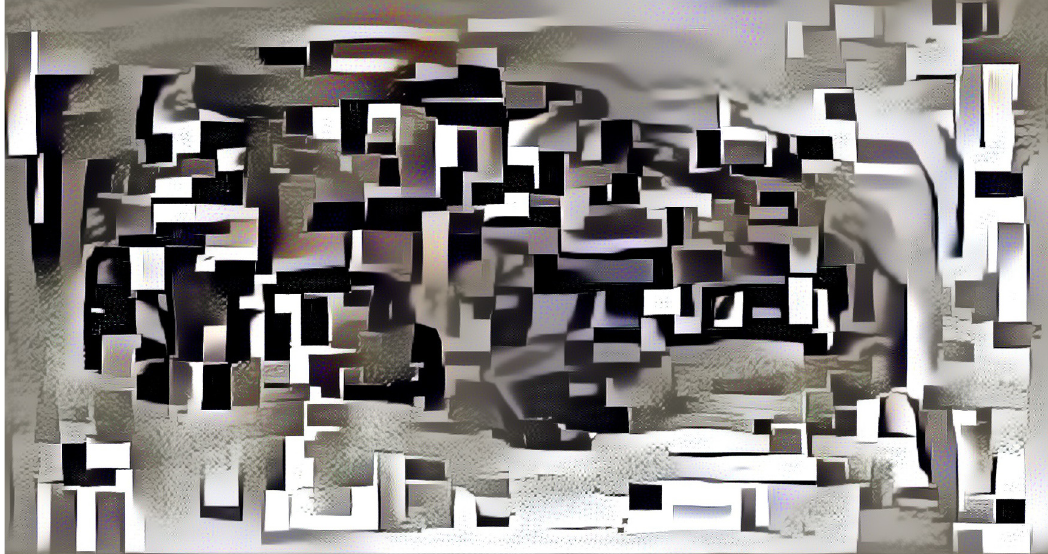
Figure 9: Trace and Trace I , 2020 ( Di ff ractive Image – style transfer QR w3w location code and fl int RTI ) .